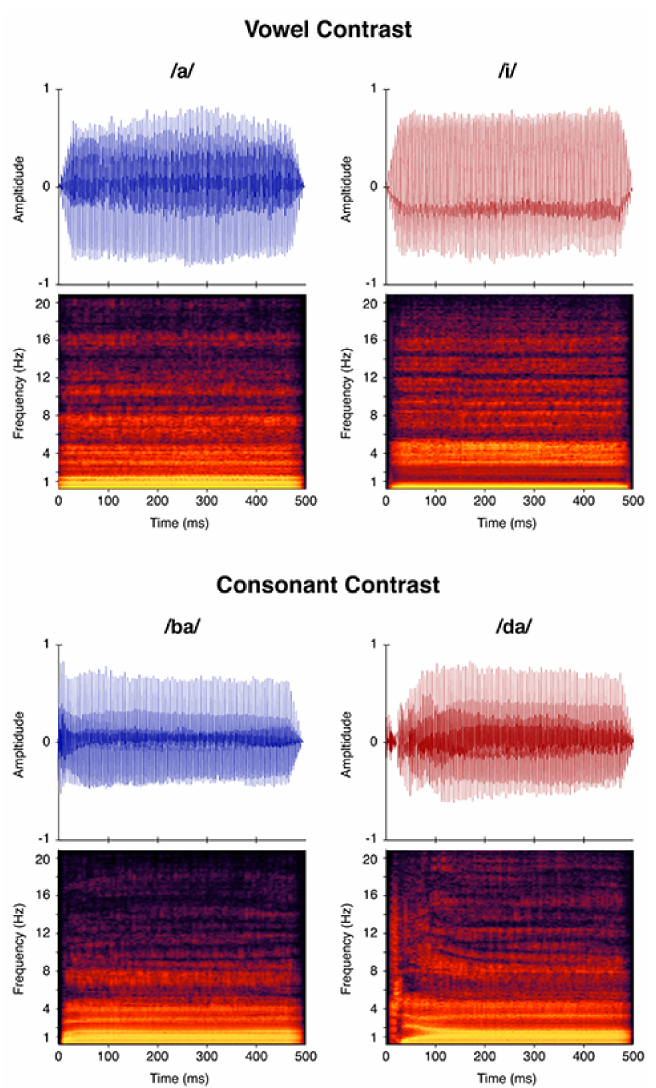
Figure 1. Time-amplitude waveforms and spectrograms for stimuli tested during the speech percep- tion task. The top panel shows the /a/ and /i/ speech sounds for the vowel contrast and the bottom panel shows the /ba/ and /da/ speech sounds for the